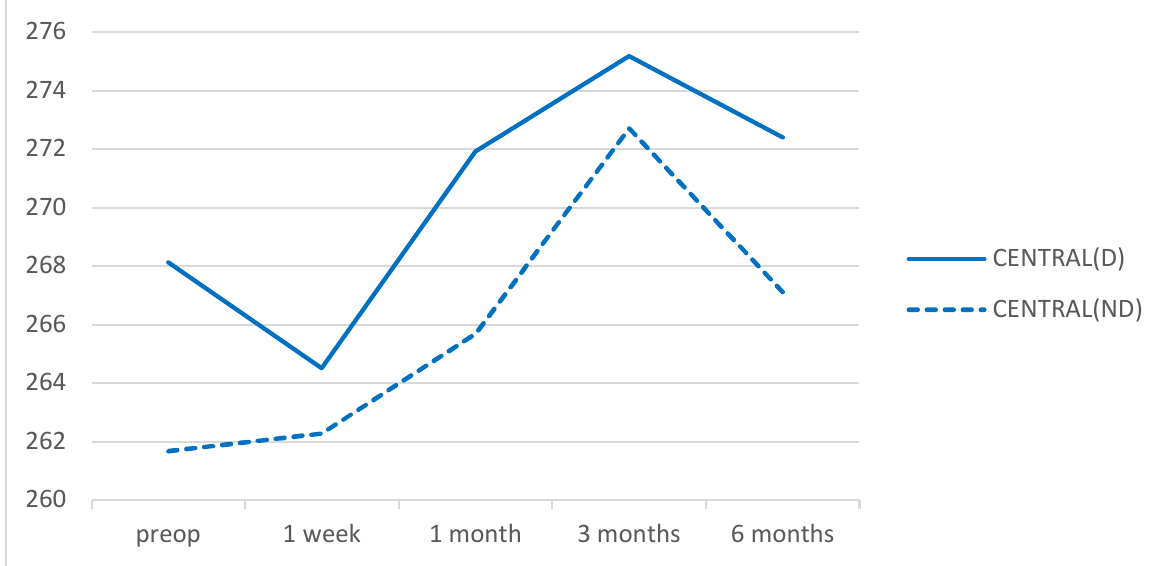
Figure 2. Mean values of the retinal thickness in the central area of the 1 mm diameter ring for DM patients and non-diabetic subjects during the follow-up time points. Values are expressed in mi- crons.